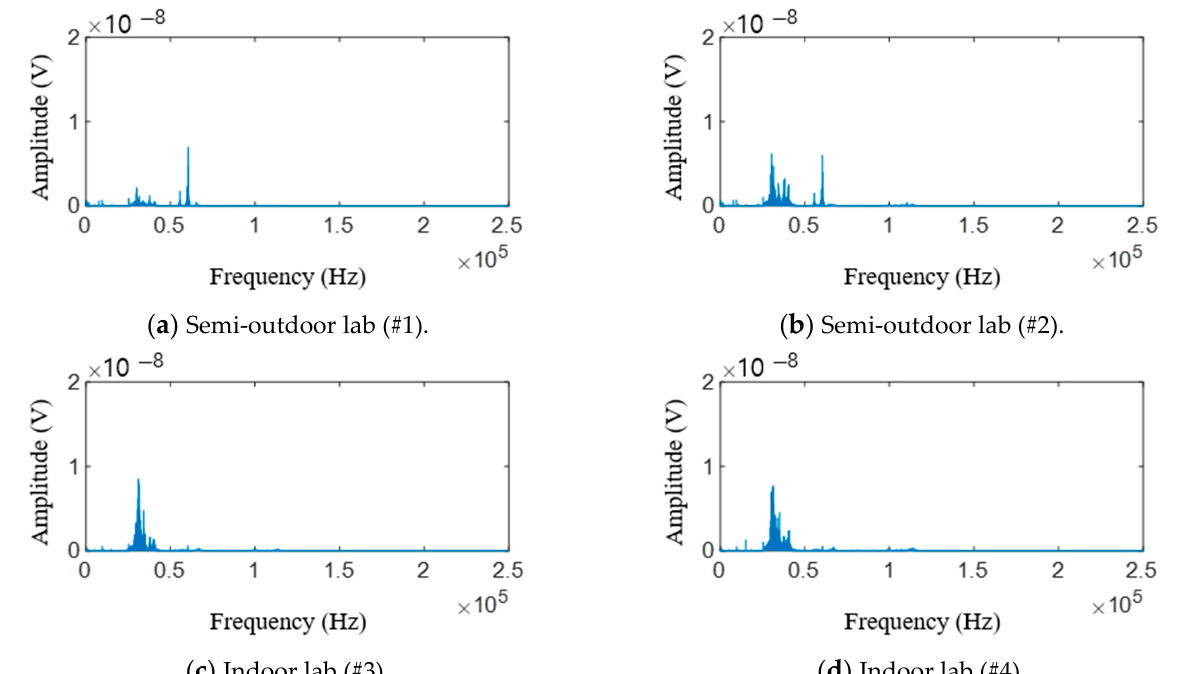
Figure 10. AE raw signal with press process.